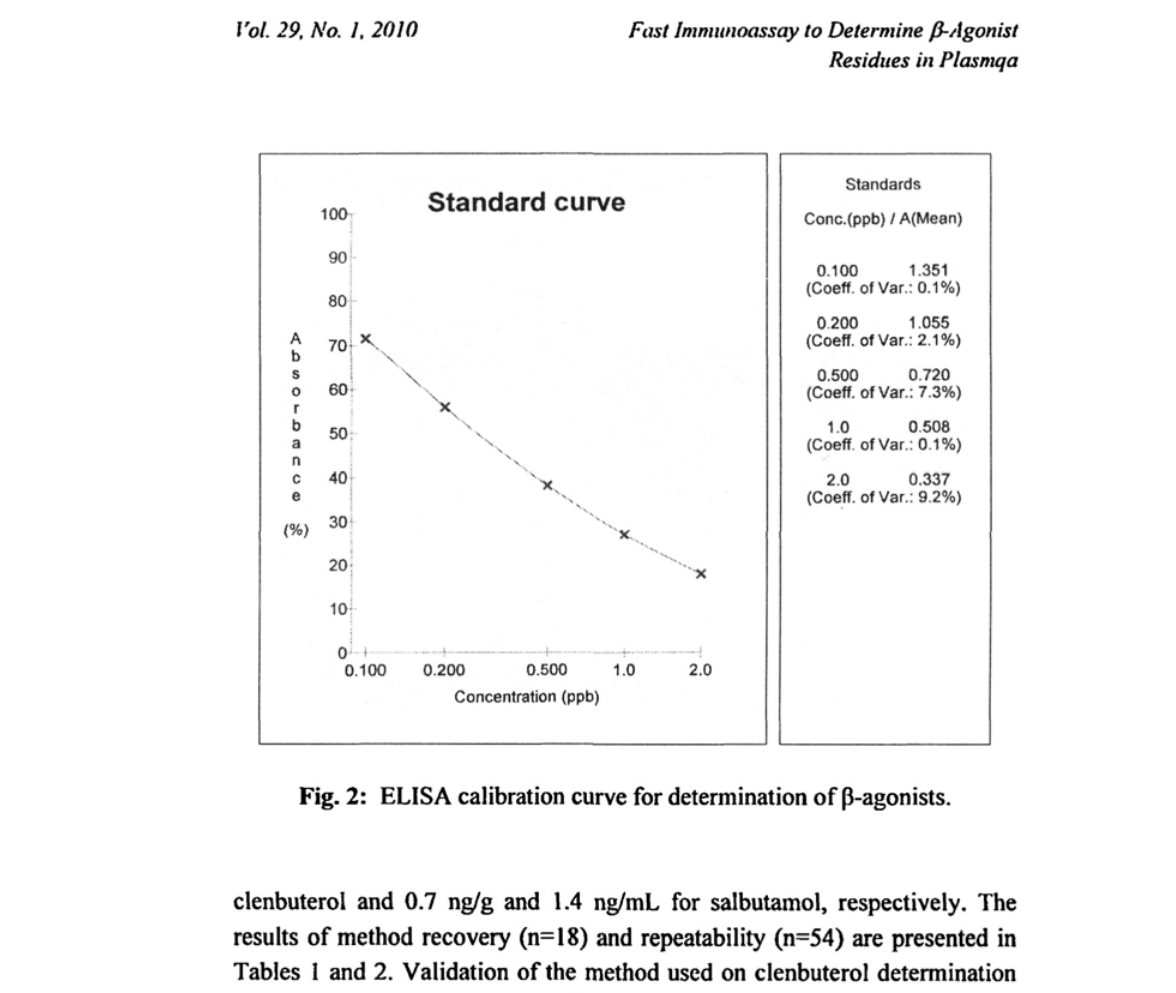
Fig. 2: ELISA calibration curve for determination of ß-agonists.